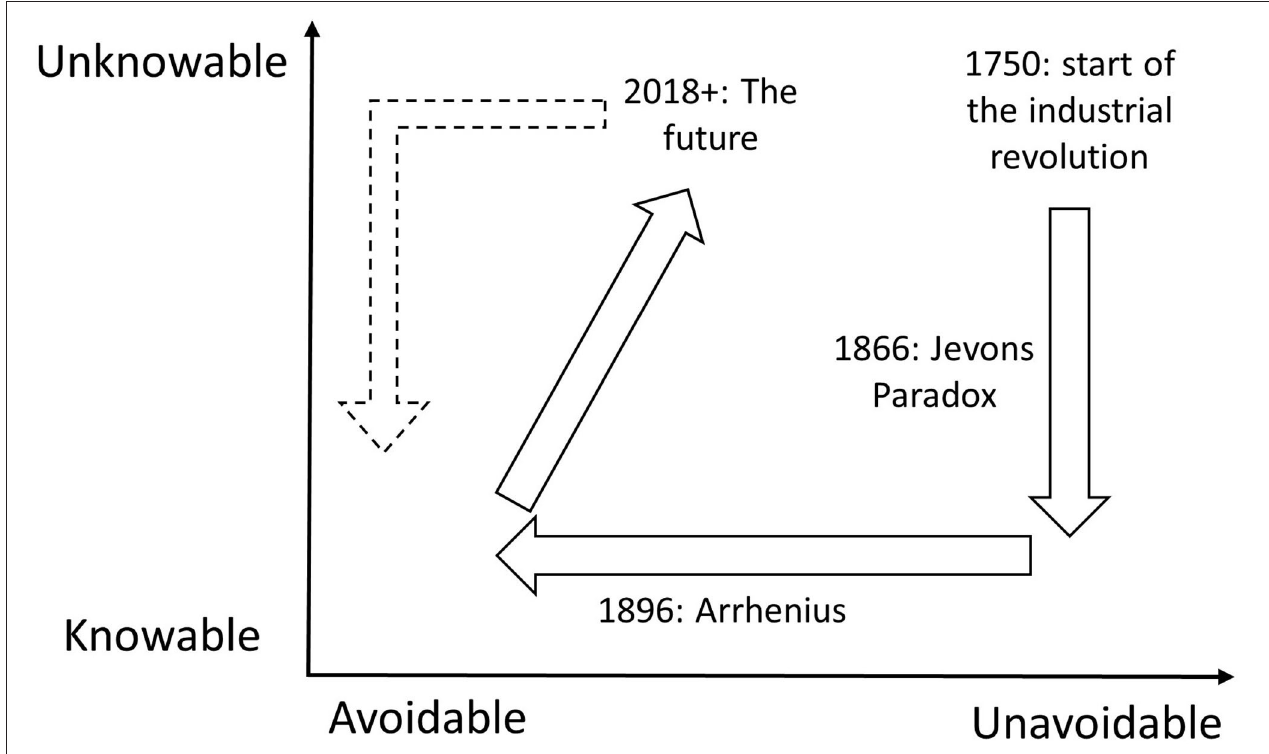
FIGURE 2 | Transitions of climate change throughout